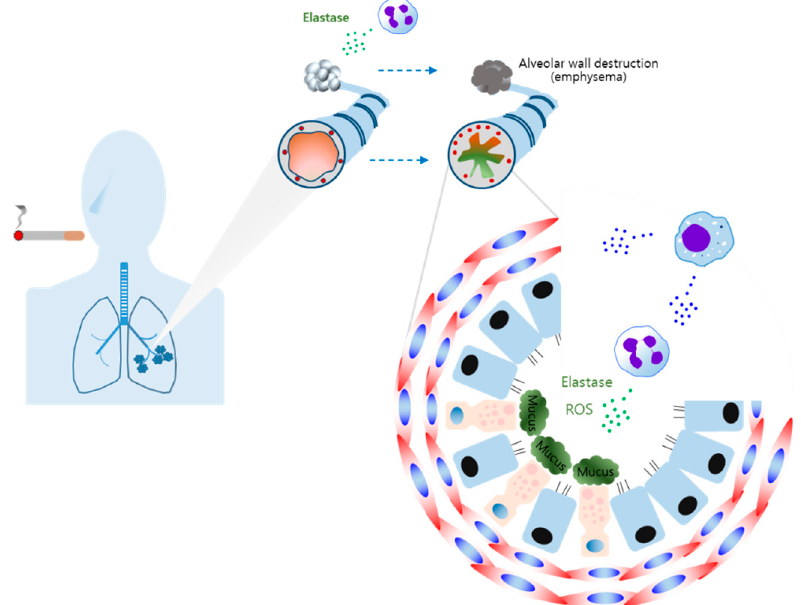
Figure 4. The macrophages in chronic obstructive pulmonary disease (COPD). Tobacco smoking causes airway inflammation, emphysema, and airway remodeling. Neutrophils and macrophages are key inflammatory cells in the pathogenesis of COPD. Neutrophil-derived ROS and elastase promote mucus hypersecretion and emphysema. Macrophages secrete inflammatory cytokines and chemokines, promoting neutrophil recruitment and levels of neutrophil-associated molecules, such as elastase and ROS. Macrophages also are involved in fibrotic remodeling.